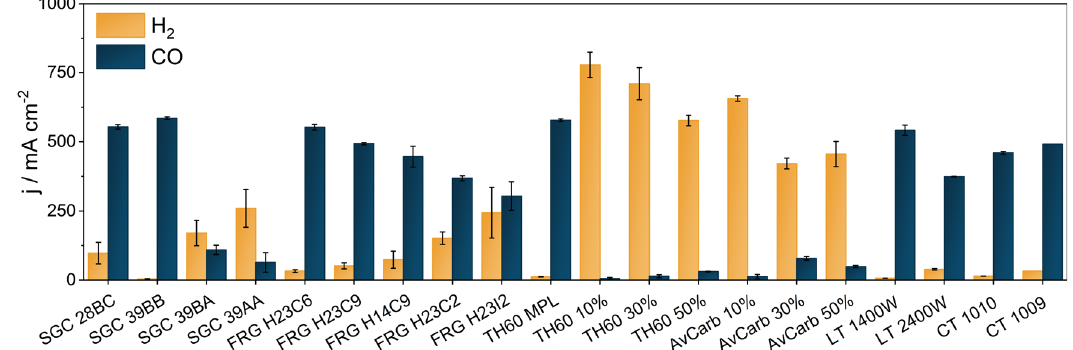
Fig. 1 Comparing commercially available carbon gas diffusion layers-based gas diffusion electrodes in the CO 2 reduction reaction. Partial current densities for CO (blue) and H 2 (yellow) production during 1-hour long chronoamperometric CO 2 reduction reaction measurements at Δ U = 3.0 V, applying different GDL based cathode GDEs with Ag catalyst. The electrolyte solution was 0.1 M CsOH, humidi fi ed CO 2 was fed to the cathode at a fl ow rate of 12.5 cm 3 cm − 2 min − 1 and the temperature of the electrolyzer cell was 60 °C. The error bars represent the deviations of two consecutive analyses during the same measurements.